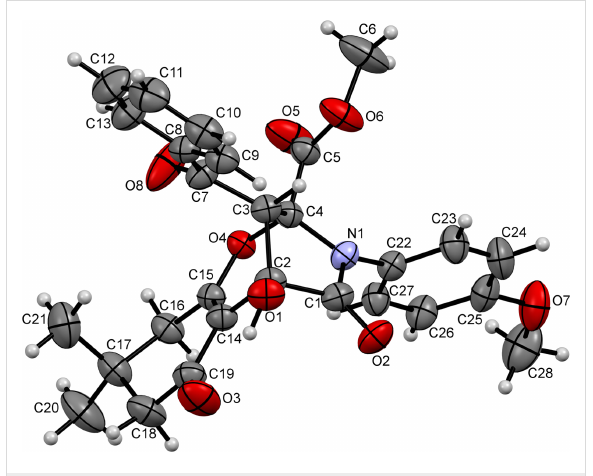
Figure 1: ORTEP drawing of compound 12ab (CCDC 1546062) showing 50% probability amplitude displacement ellipsoids.